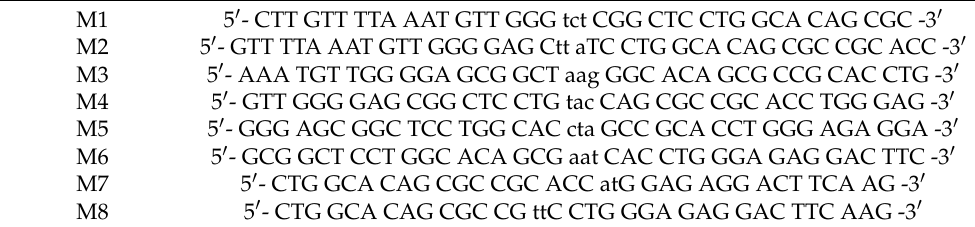
Table 2. Sequence of the oligonucleotides used to generate the various mouse Insl3 promoter mutant